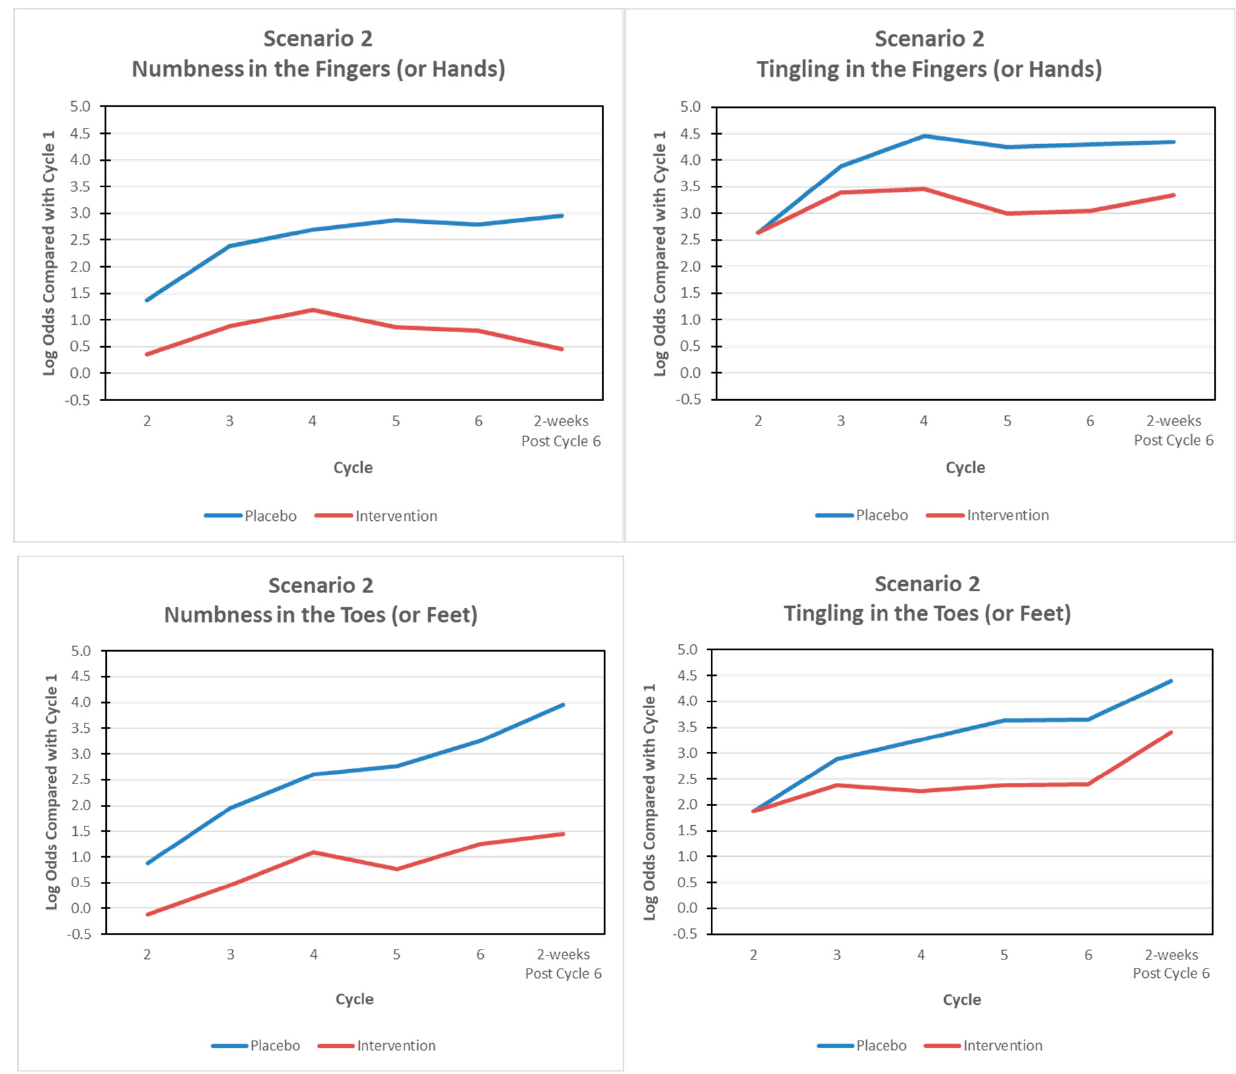
Figure 3. Design Application. Scenario 2: An arm-by-treatment interaction such that a large effect for numbness, a moderate effect for tingling and no effect for shooting/burning pain was assumed. The log odds compared with cycle 1 (baseline) for the placebo arm (blue) were based on the analysis of the pooled placebo arms from two recently completed OIPN prevention trials (NCCTG N08CB;